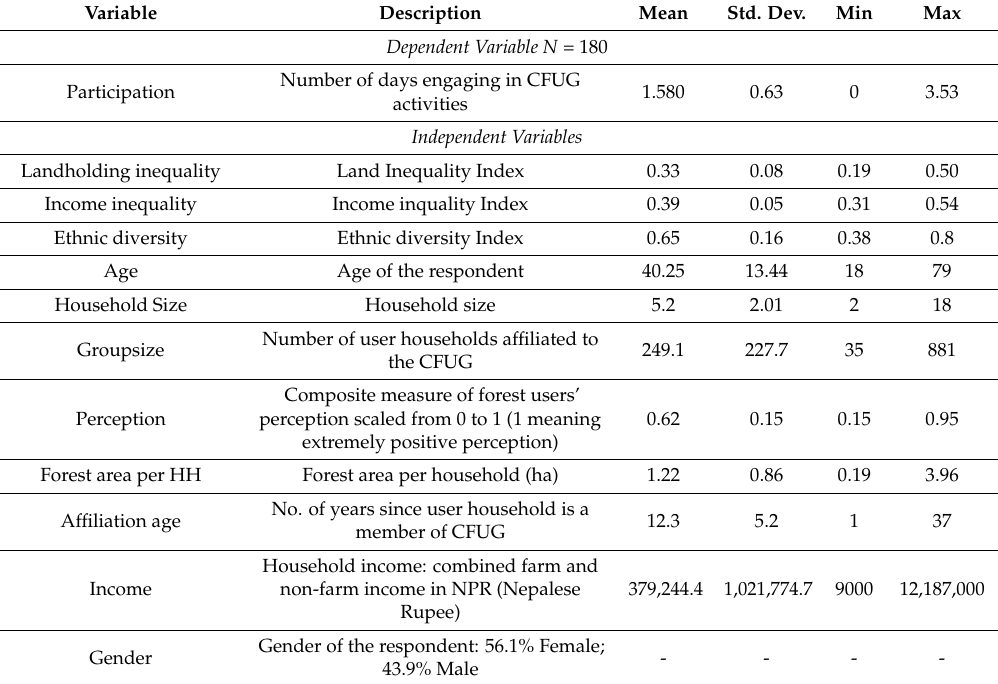
Table 7. Summary statistics of the variables included in the regression analysis (N = 180). Variable